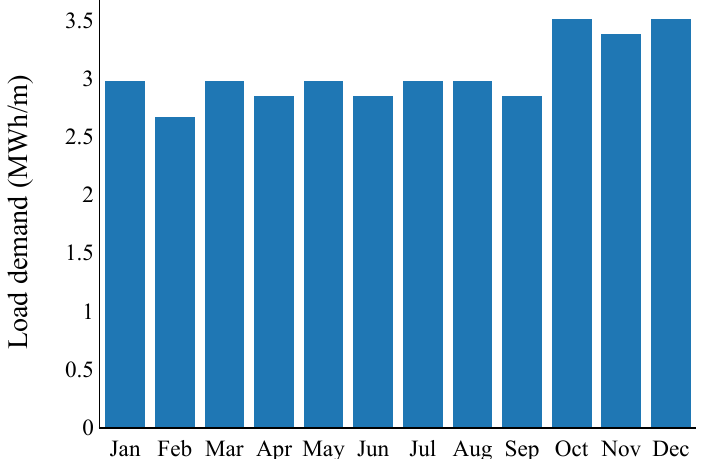
Figure 4. Monthly load profile for one year.